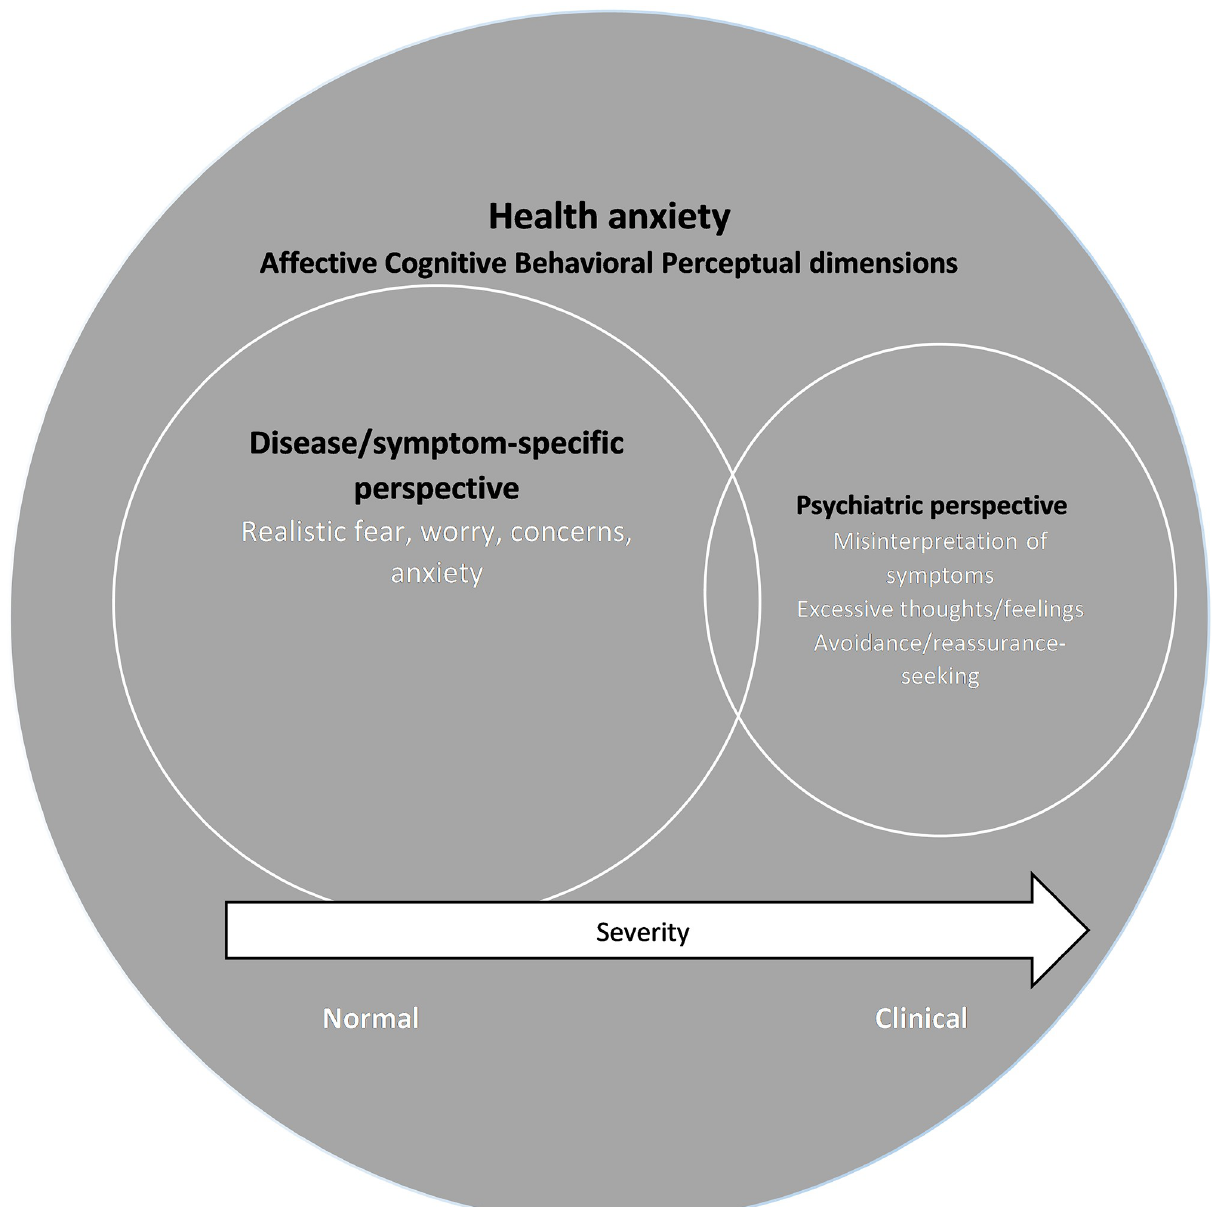
Fig 2. The conceptual relationships between HA, the disease/symptom-specific perspective, and the psychiatric perspective of fears of illness/ symptoms recurring or worsening in chronic diseases.